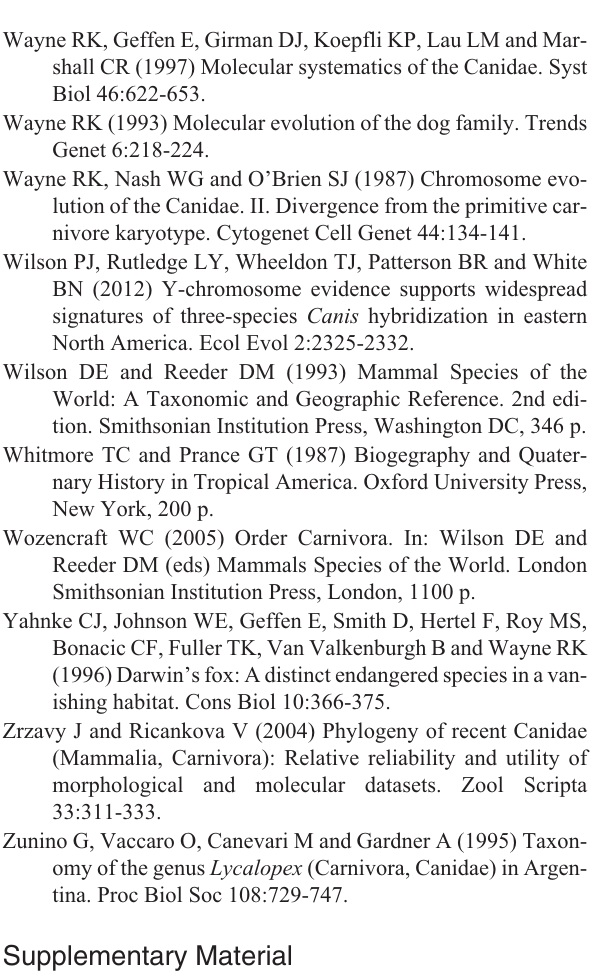
Table S1 - Samples analyzed in the present study. Figure S1 - Phylogenetic relationships among Lycalopex